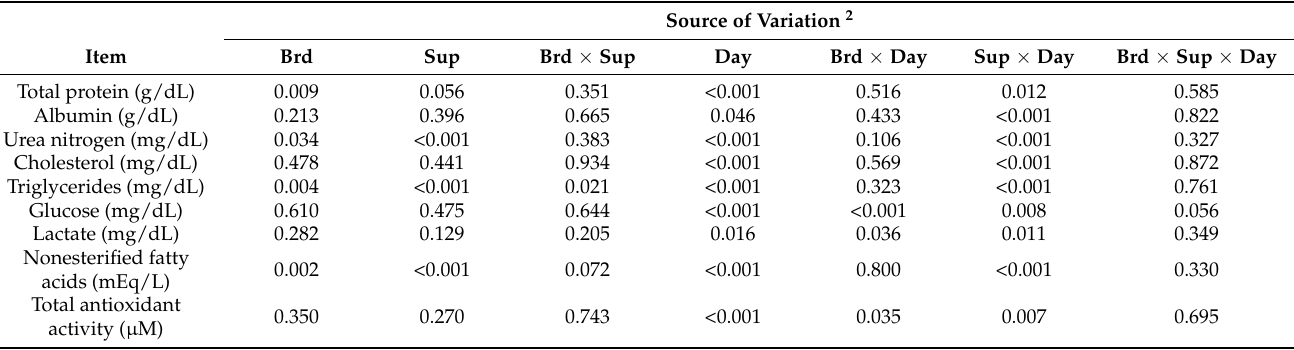
Table 7. p -values for effects of breed, supplement treatment, and day on blood constituent concentra- tions in hair sheep 1 . Source of Variation